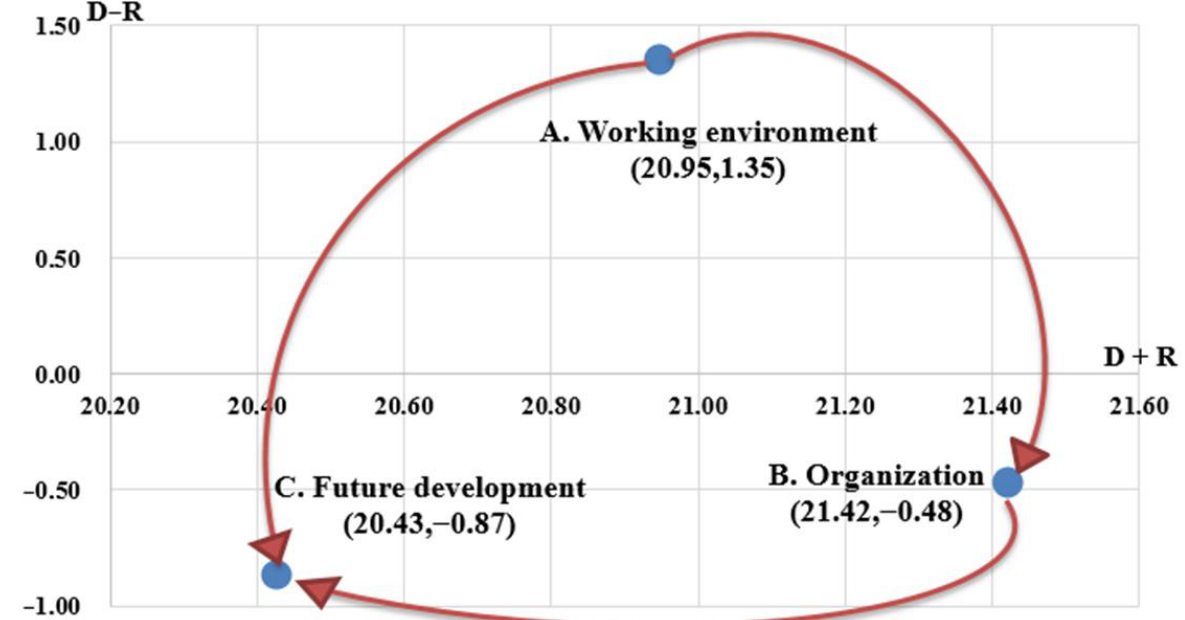
Figure 2. The impact digraph map of dimensions.